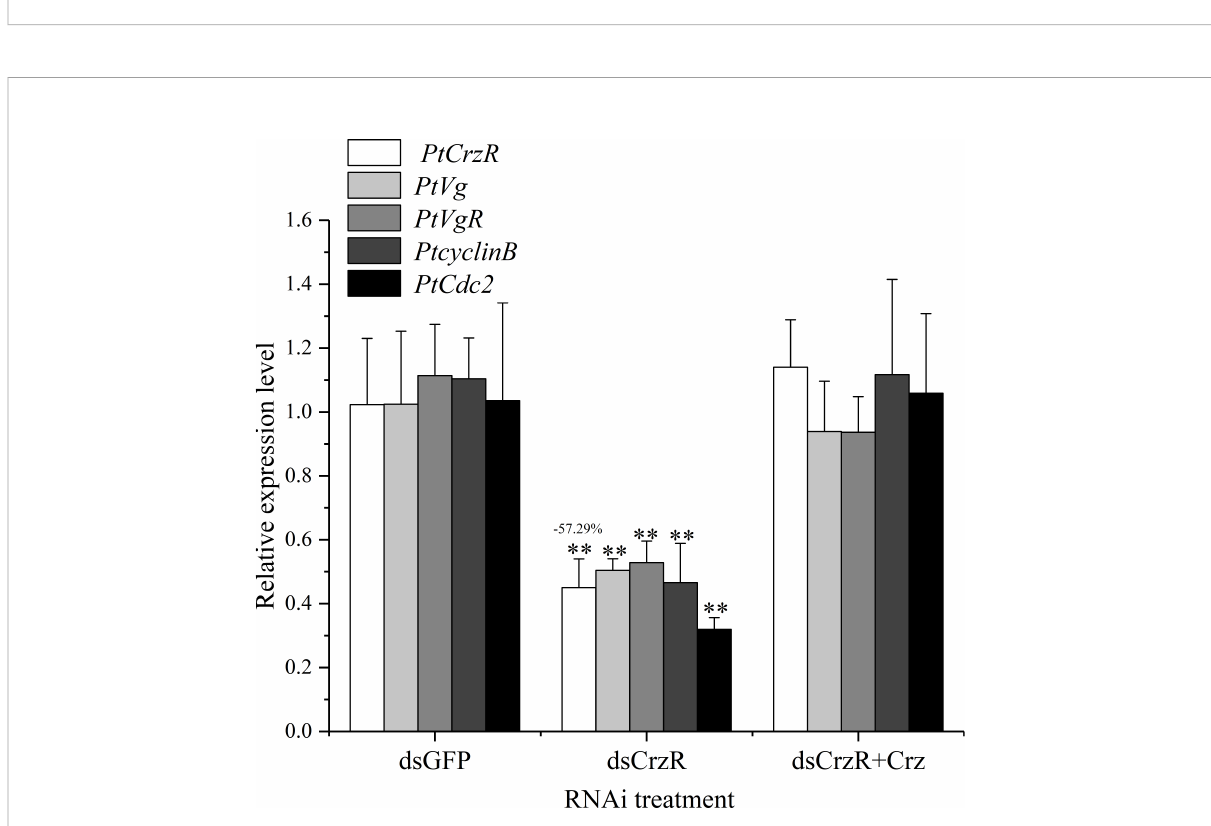
FIGURE 7 Effect of CrzR dsRNA on the expression of PtCrzR , PtVg , PtVgR , PtcyclinB , and PtCdc2 in the ovary explants from P. trituberculatus . Data are shown as mean ± SE (n=4). “ ** ” represents extremely signi fi cant differences ( P < 0.01) from the control